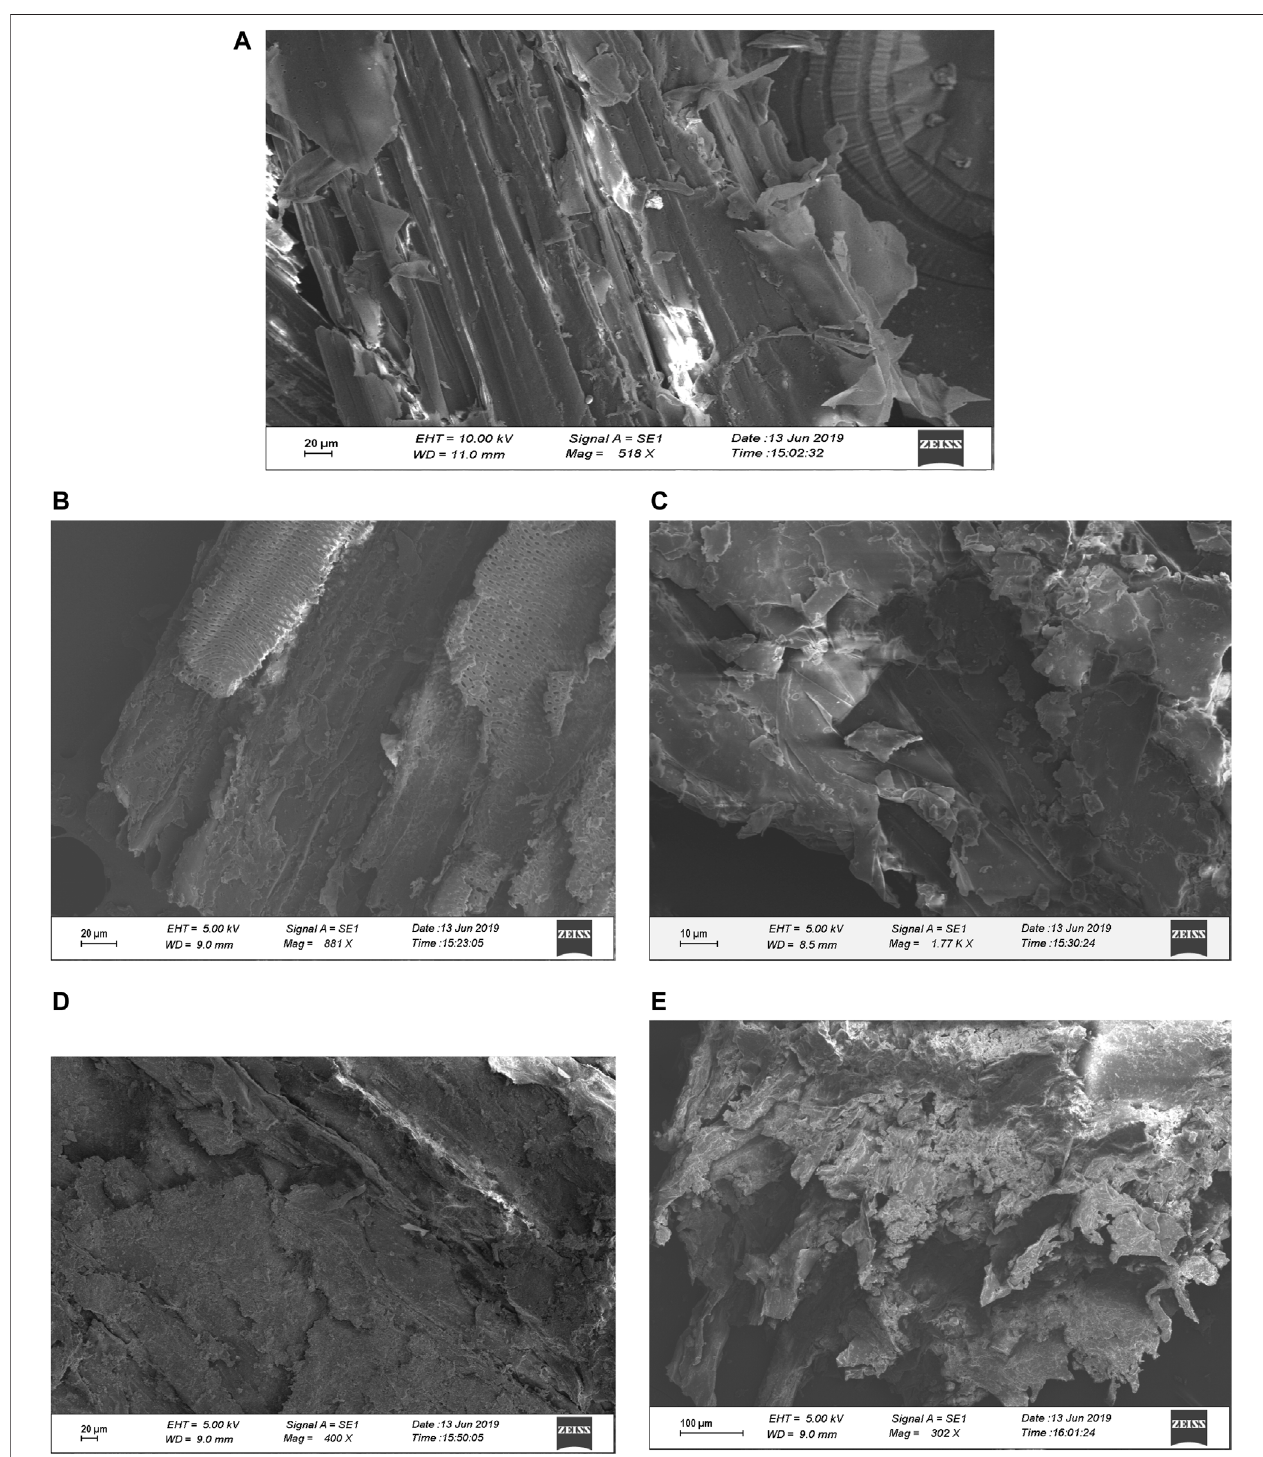
FIGURE 3 | Scanning electron microscopic (SEM) analysis of sugarcane bagasse (SB). (A) Showing the surface image of untreated sugarcane bagasse, (B) 10% sulfuric acid-pretreated bagasse at 121 ° C for 30 min, (C) 10% sulfuric acid-pretreated bagasse at 121 ° C for 60 min, (D) 10% sodium hydroxide-pretreated bagasse at 121 ° C for 30 min, and (E) 10% sodium hydroxide-pretreated bagasse at 121 ° C for 60 min. SB, sugarcane bagasse; SEM, scanning electron microscopy.